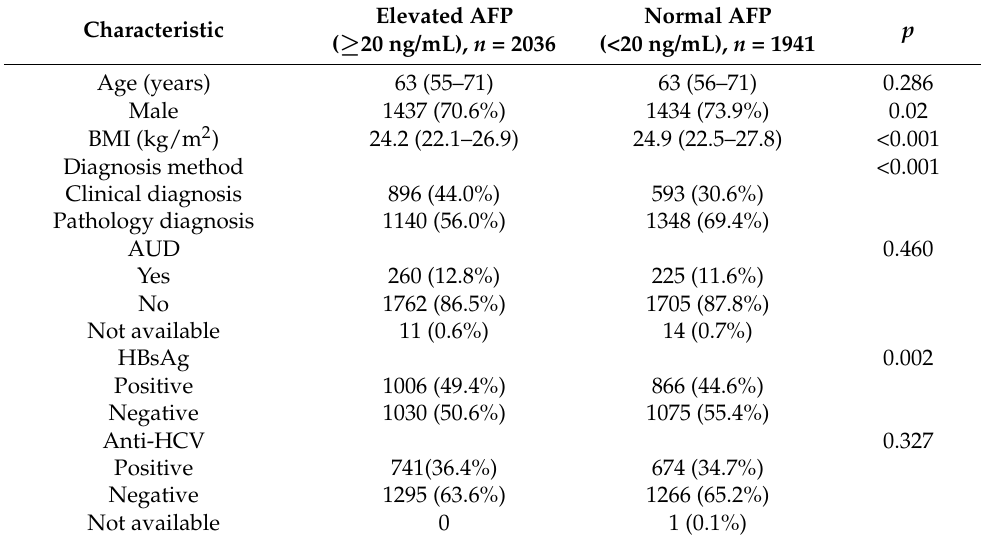
Table 1. Patients’ characteristics categorized by alpha-fetoprotein level.